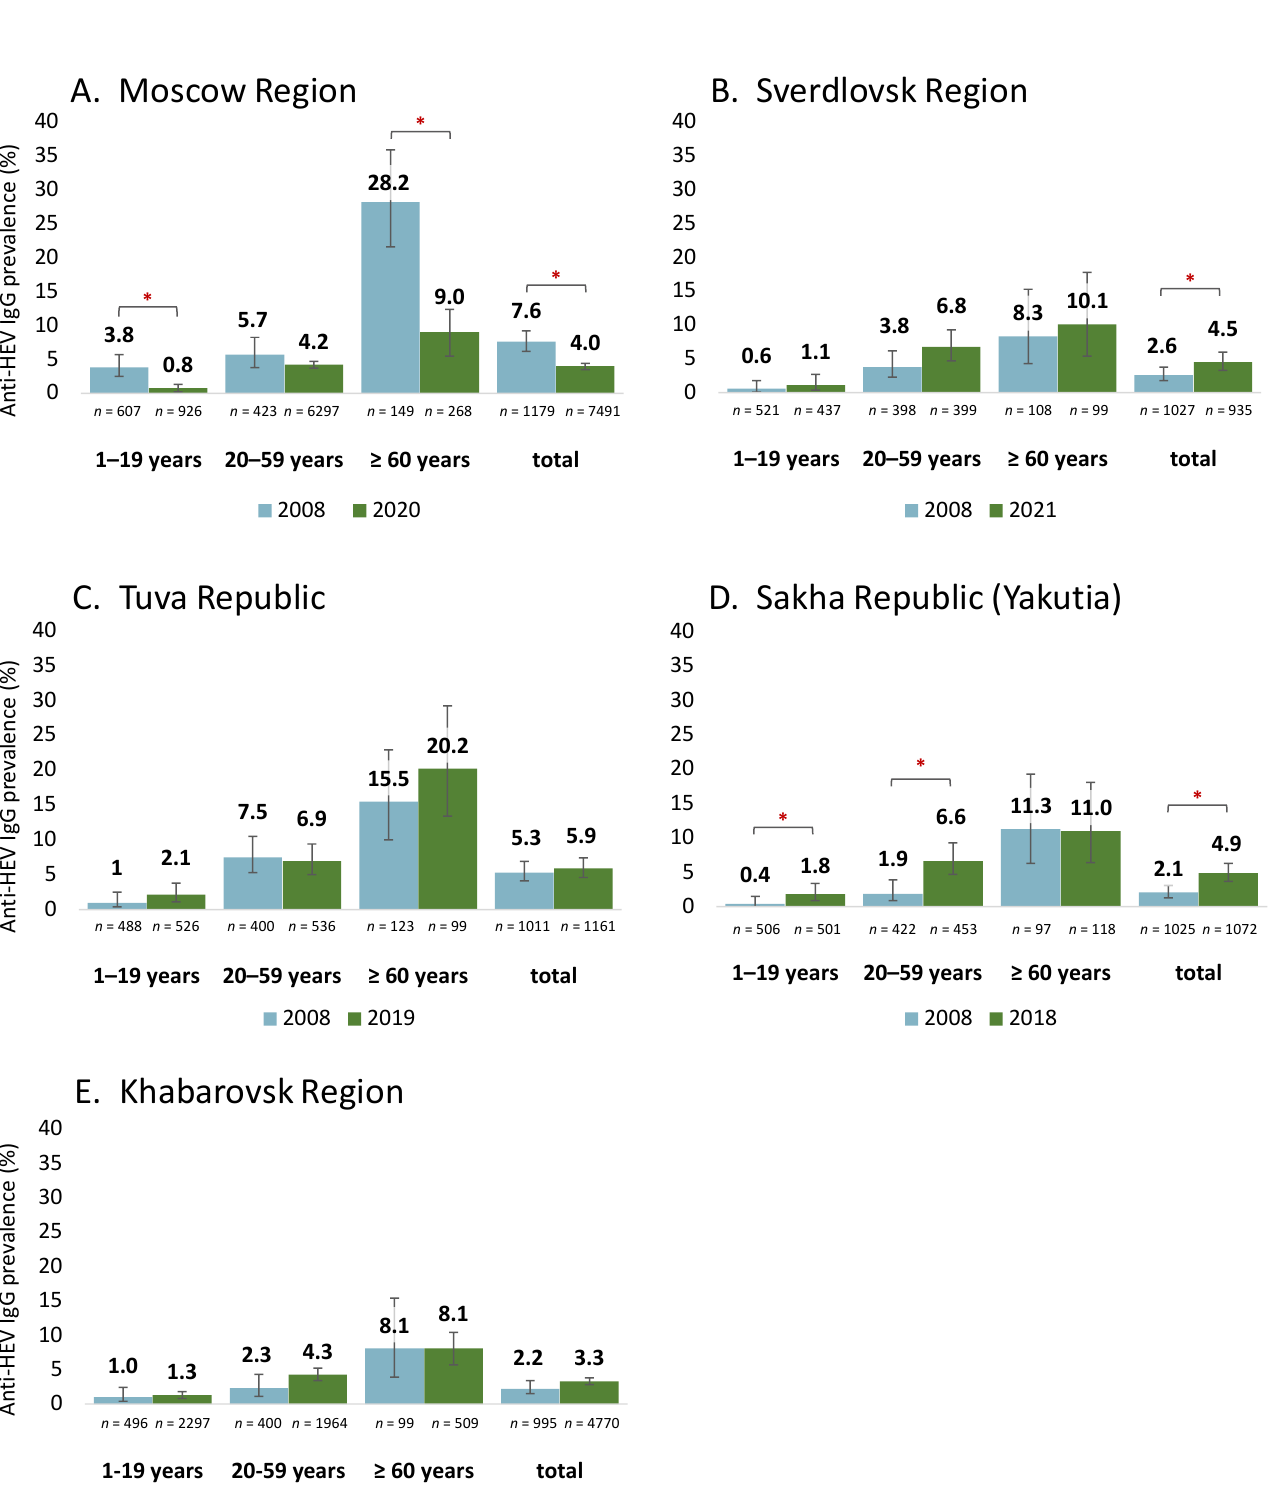
Figure 3. Comparison of anti-HEV IgG antibody prevalence rates in the general population of Russia in 2008 compared with 2018–2021. p values (Fisher’s exact test) > 0.05 between groups surveyed in different years are indicated with an asterisk. Error bars on the bar graphs represent 95% CI.